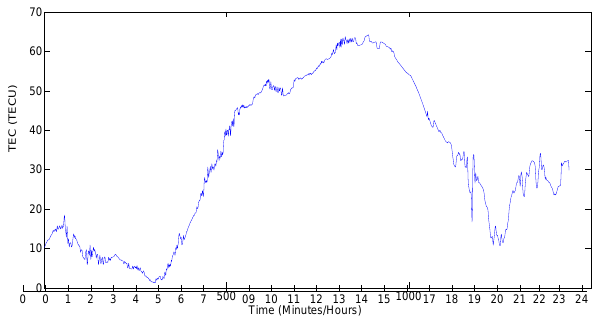
Figure 2. The detrended time series plot for TEC measured at La-